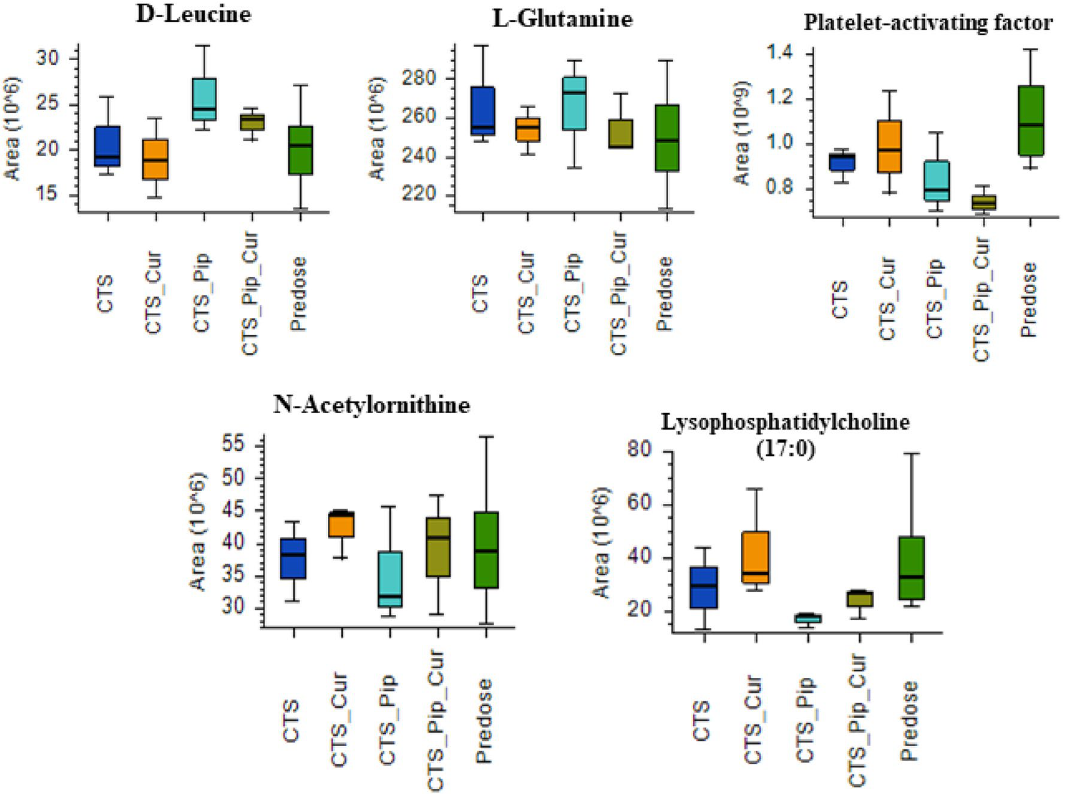
Figure 4. Boxplots of the metabolite biomarkers that changed 4 h after administration of Centella asiatica (CTS) extract alone, in combination with curcumin (CTS_Cur), in combination with piperine (CTS_Pip) and in combination with both curcumin and piperine (CTS_Pip_Cur) in the positive mode of